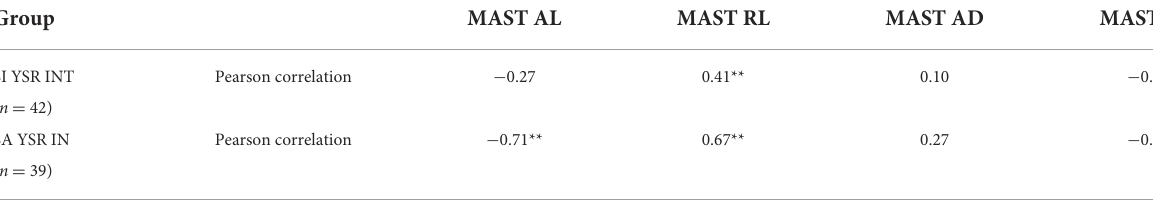
TABLE 5 Characterization of suicidal attitude using MAST scale in patients presenting internalizing problems (INT) at YSR 11–18. Group MAST AL MAST RL MAST AD MAST RD SI YSR INT Pearson correlation − 0.27 0.41** 0.10 − 0.12 ( n = 42) SA YSR IN Pearson correlation − 0.71** 0.67** 0.27 − ( n = 39)